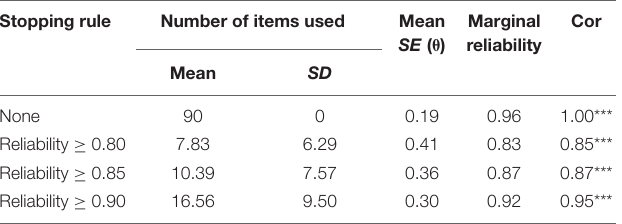
TABLE 4 | Characteristic of the CAT-SPD under several stopping rules.